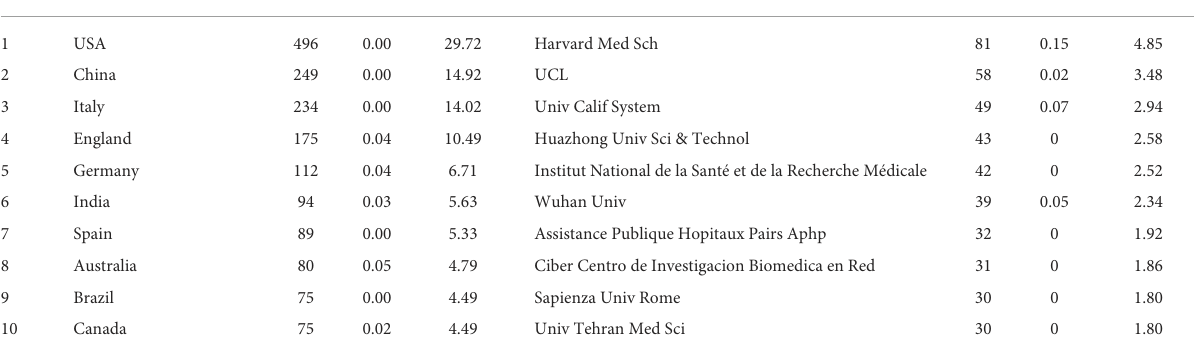
TABLE 2 Top 10 countries/regions and institutions in CVDs and COVID-19 research. Rank Countries/Regions Record BC Count (%)